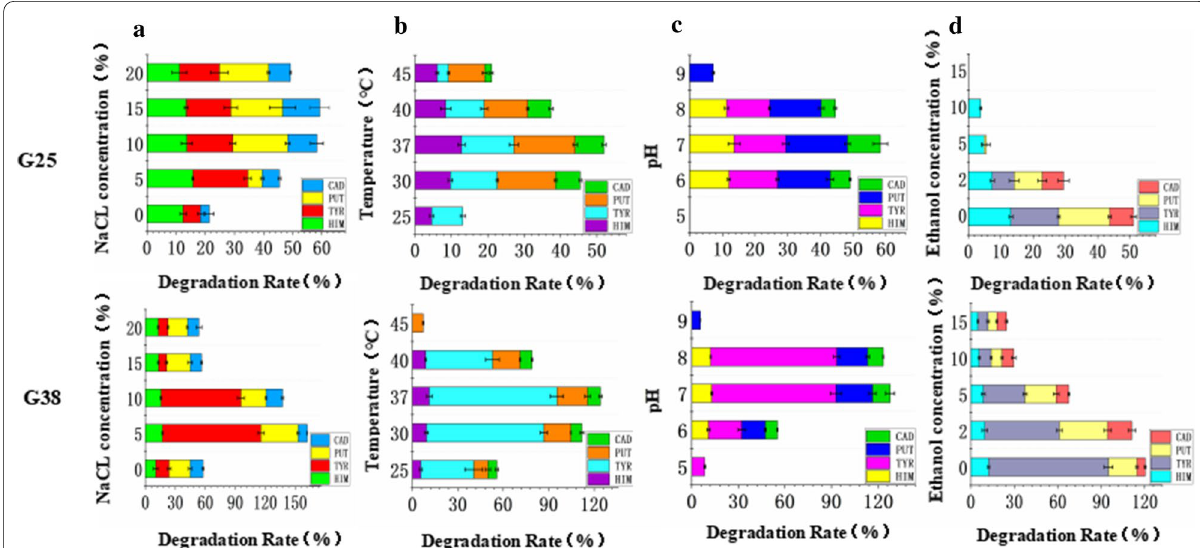
standard deviations from three determinations: a NaCl concentration. ±